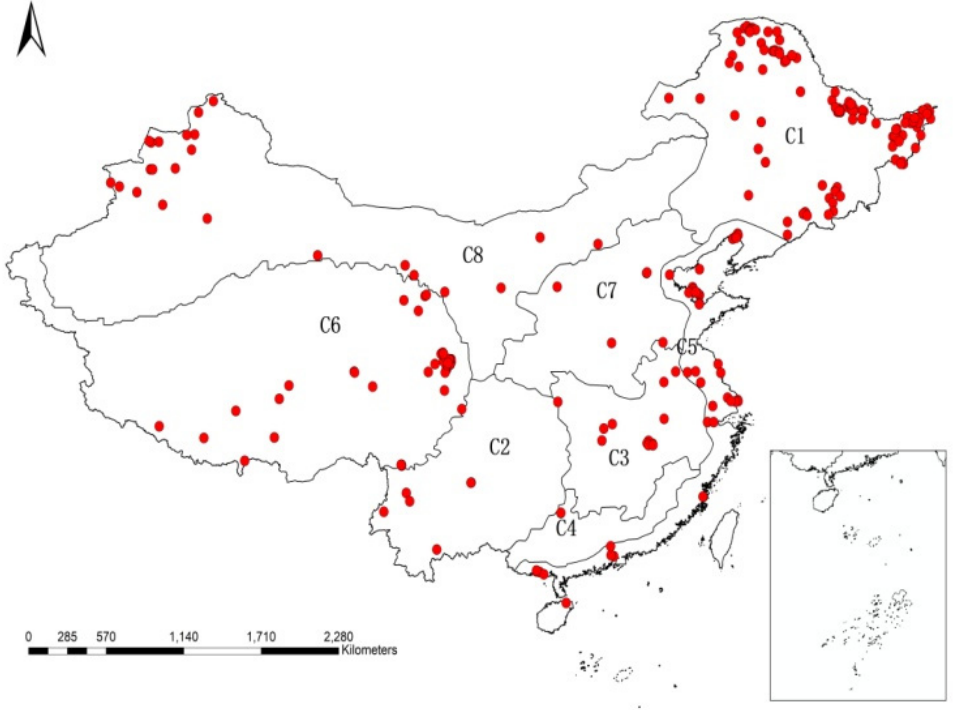
Figure 1. Selected sampling points distribution diagram.